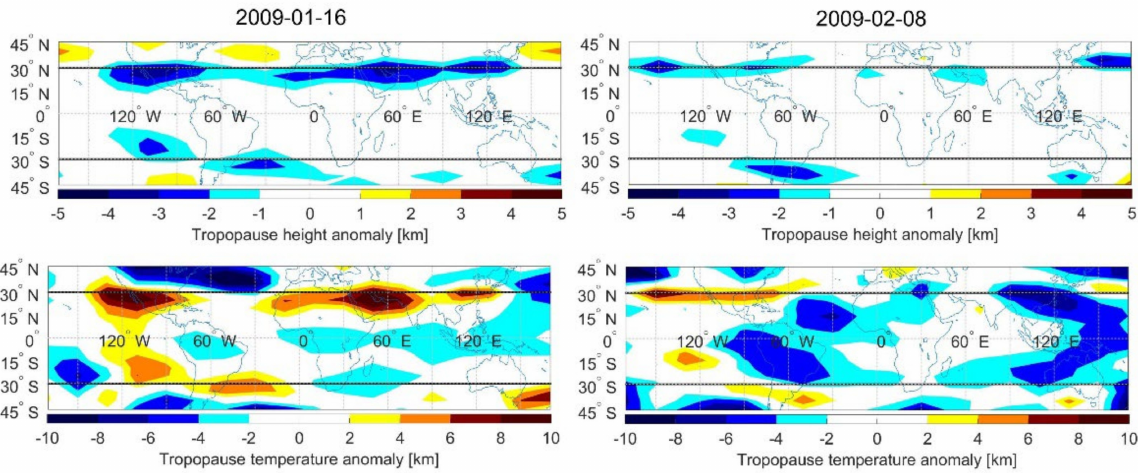
Figure 11. Latitude and longitude sectors of tropopause height and temperature anomalies on two exemplary days of 16 January and 8 February